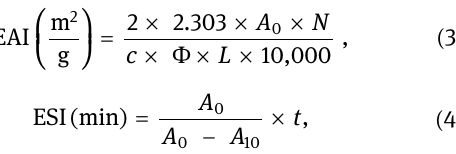
Figure 1. L - Dopa was utilized to crosslink the surface hydroxyl groups of CNC with the amino groups of SPI, forming CNC – SPI nanoconjugate. The solution color gra - dually changed from colorless to black,